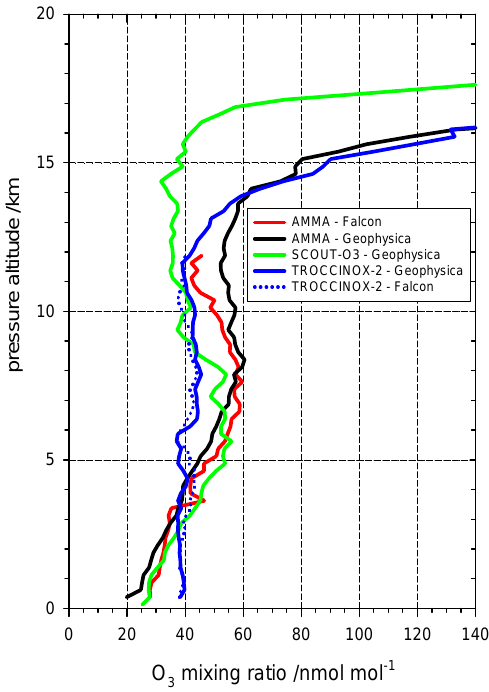
Fig. 13. Mean vertical O 3 profiles derived from measurements with the Falcon (flights 01b/04/06/07/11/13/15a-b/16/18a August 2006) and Geophysica (flights 04/07/08/11/13/16/17 August 2006) during AMMA. Superimposed are mean vertical O 3 profiles from SCOUT-O3 and TROCCINOX-2 (adapted from HH07; HH09). Mean values were calculated for every 250m altitude bin.